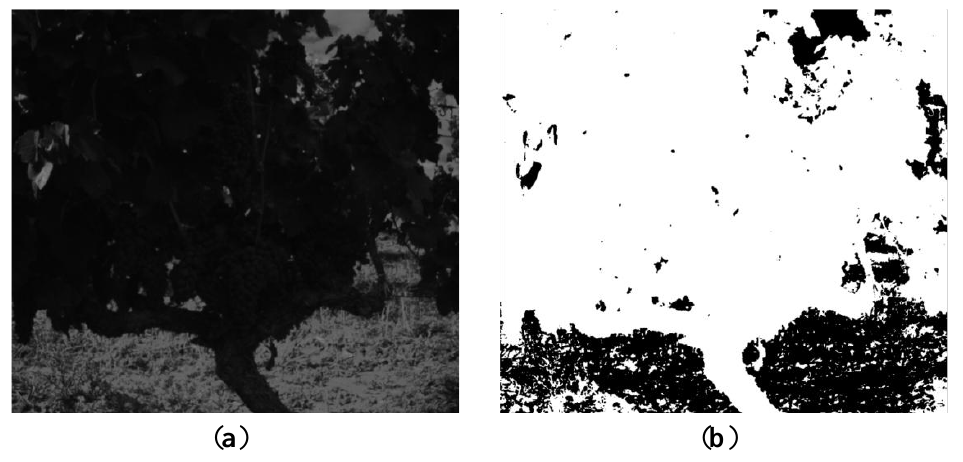
Figure 6. Step 1. ( a ) Image acquired with the optical filter whose centre wavelength is 635 nm; ( b ) K-means result: 2 clusters representing the background and the foreground.